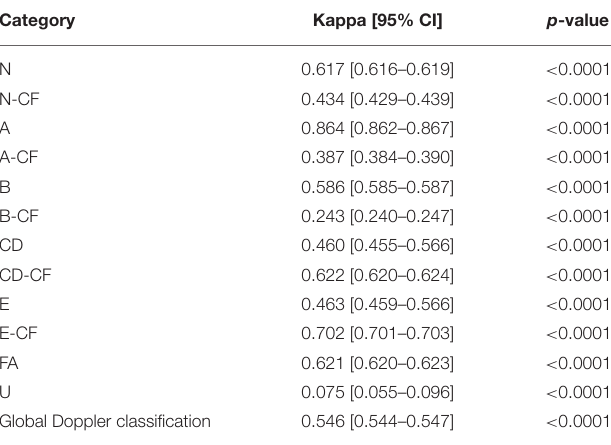
TABLE 3 | Inter rater reliability of arterial Doppler waveform classification by categories from 110 raters and 20 Doppler waveforms.